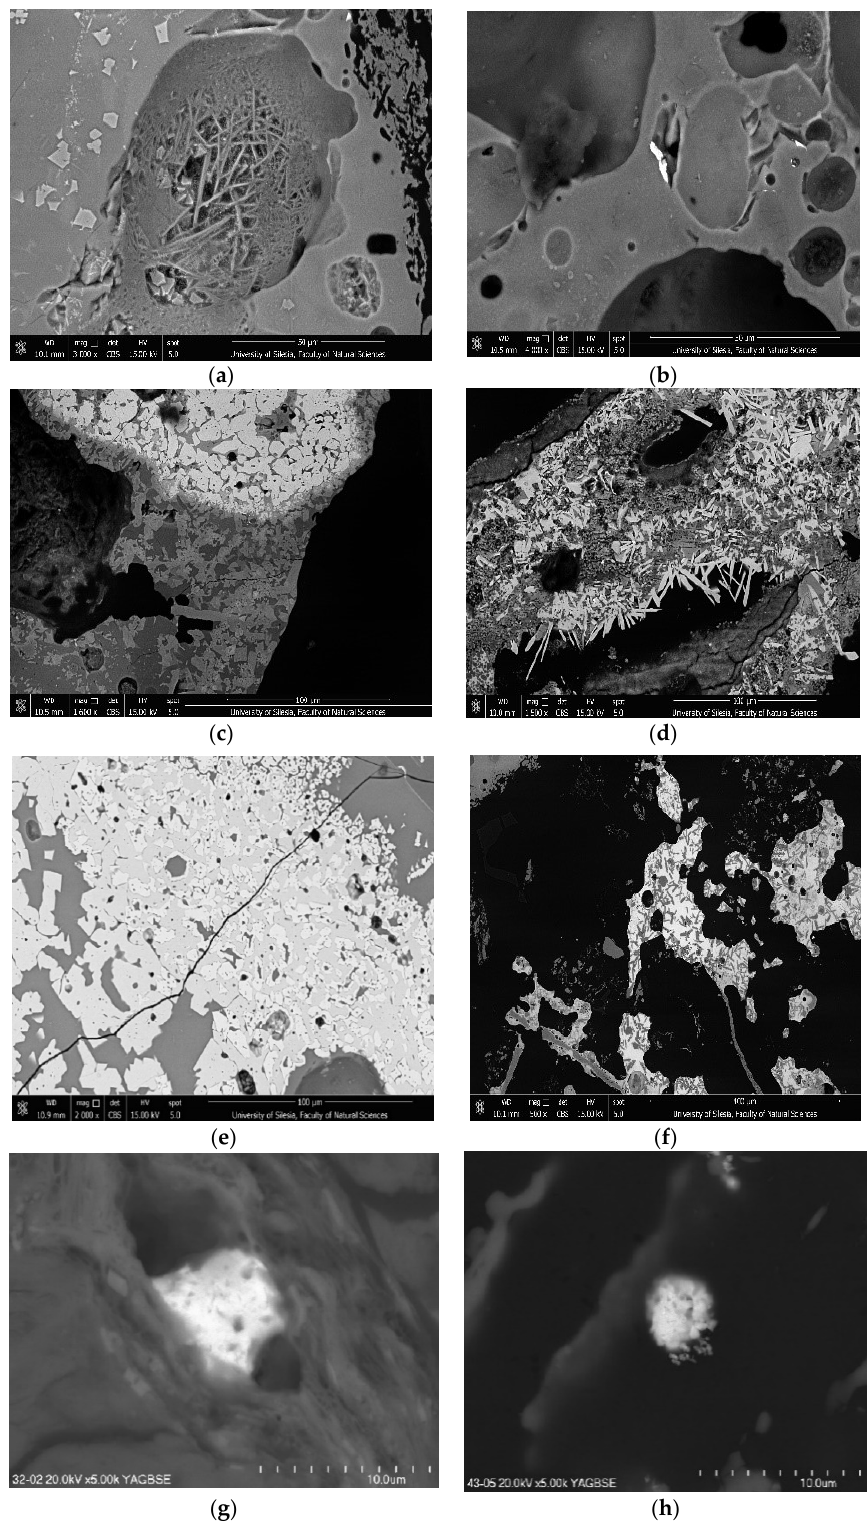
Figure 4. SEM images of the morphology of different ash particles: ( a ) mullite (needles inside); ( b ) aggregate composed of Mn, Ni, and Fe oxides (bright particle); ( c ) Fe oxides; ( d ) gypsum (bright bars); ( e ) diopside ( f ); corundum (dark on a light background); ( g ) lead sulphide; ( h ) rare earth phosphate (monazite) with Th.